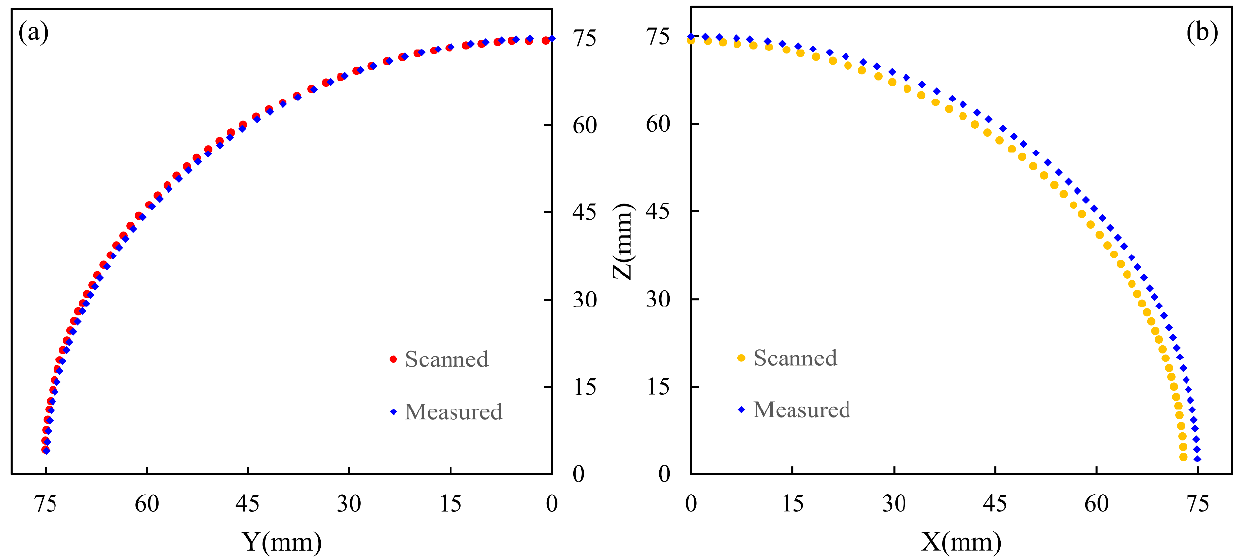
Figure 12. Yarn distance comparison results: ( a ) warp yarn profile location; ( b ) weft yarn profile location.